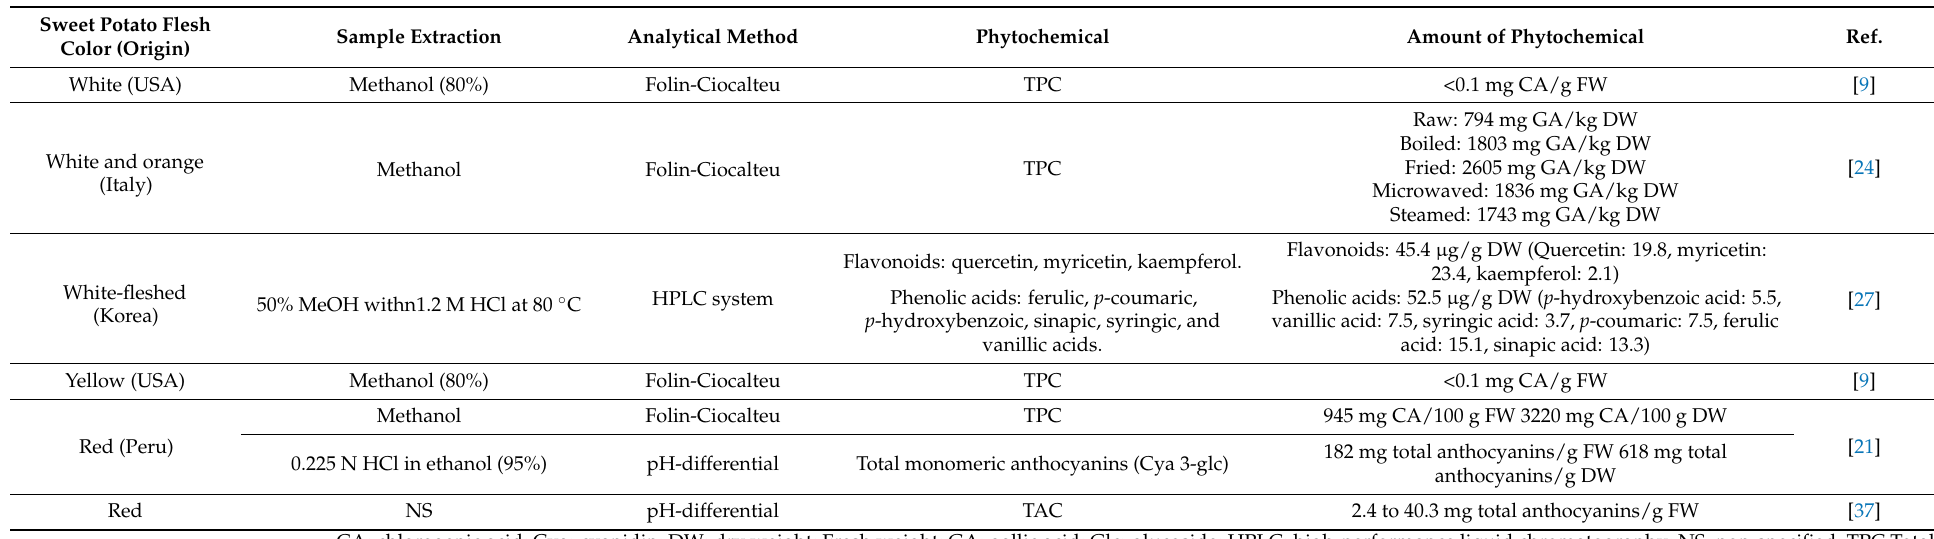
Table 3. (Poly)phenol content of white, yellow, and red sweet potato